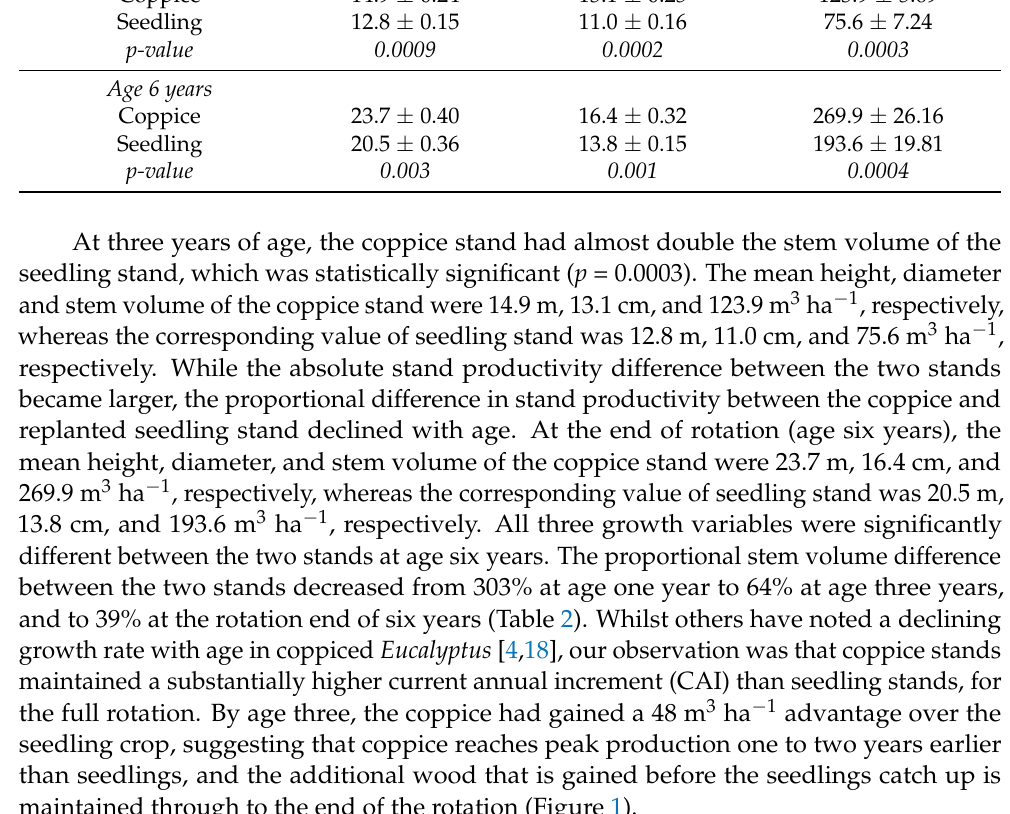
Table 2. Growth of the coppice and replanted seedling stand of Eucalyptus pellita.